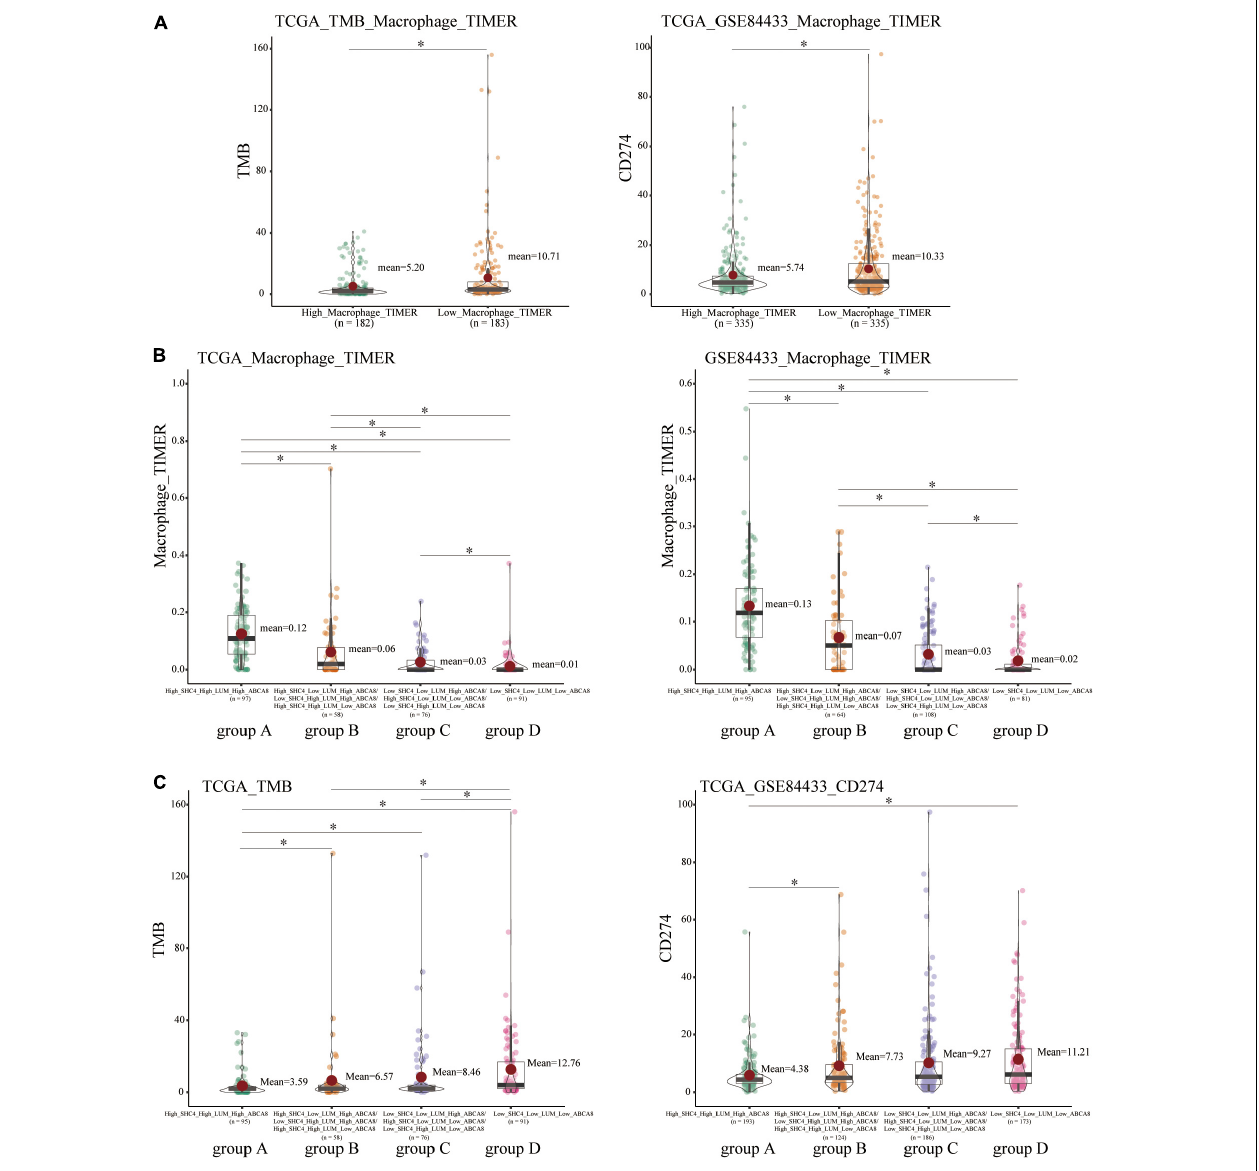
FIGURE 9 | Correlation of macrophage abundance, 3-gene signature, and immunotherapy biomarkers, including tumor mutational burden (TMB) and PD-L1 (CD274). (A) Compared with high macrophage group, low macrophage group had higher TMB and PD-L1 expression. (B) There were significant differences in the abundance of macrophages in 4 groups of STAD patients divided by the 3-gene signature. (C) Among 4 groups of STAD patients, there were significantly differences among group A, group B, and group D on the TMB and PD-L1. * p < 0.05.